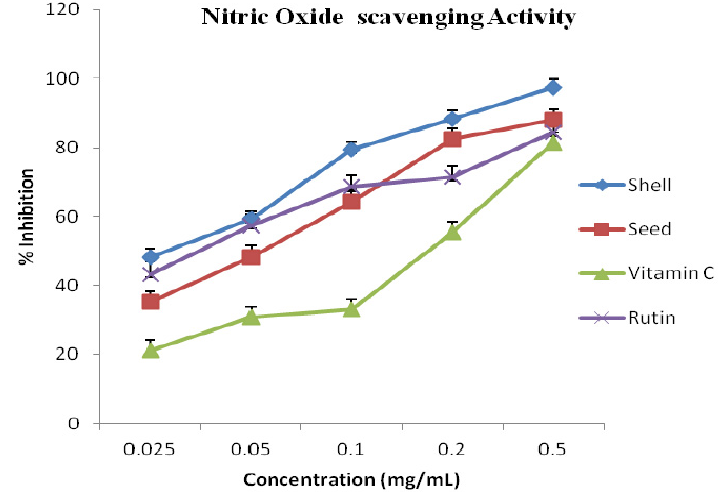
Figure 4. Antioxidant activity of the shell and seed essential oils extracted from A. precatorius on nitric oxide